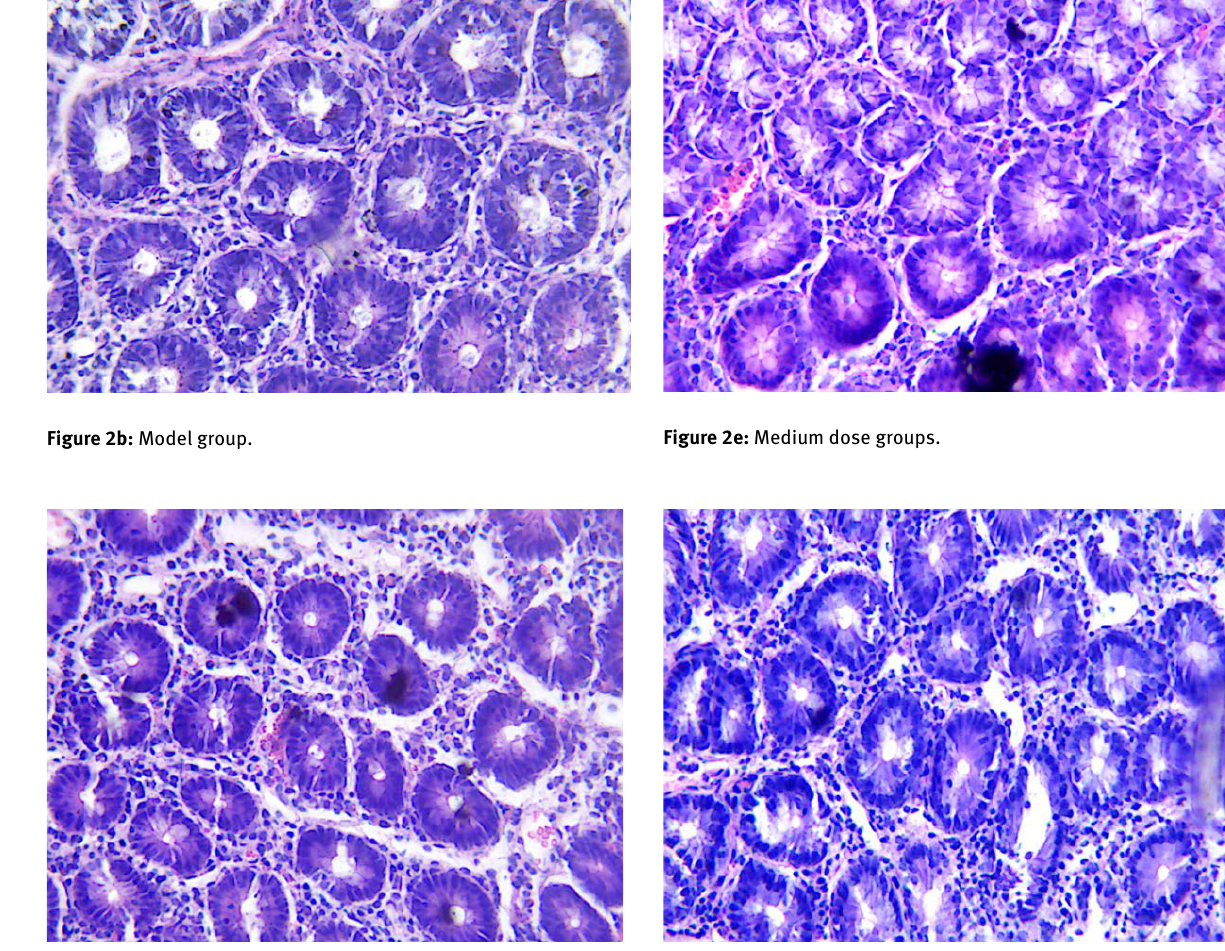
Fi gur e 2 f: L o w dose